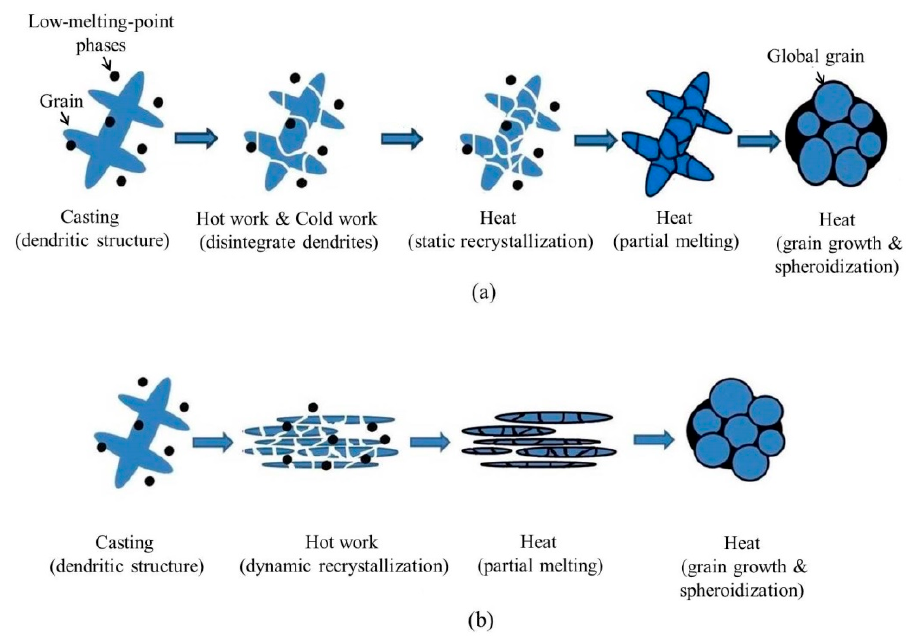
Figure 12. Evolution of globular grain formation: ( a ) traditional three ‐ step SIMA process and ( b ) proposed two ‐ step SIMA process.